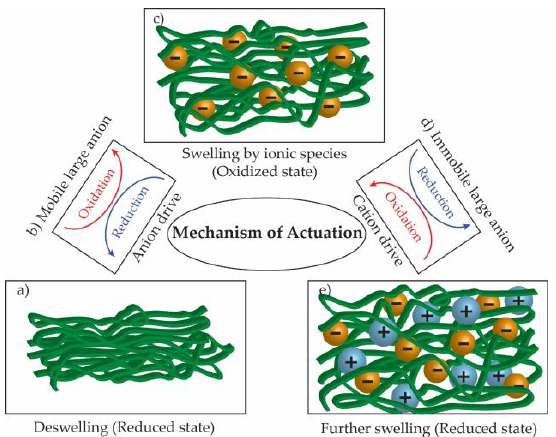
Figure 9. Mechanism of electrochemo-mechanical actuation in CPs. ( a, c, e ) Volume changes in CP via ( b , d ) two different redox pathways. ( b , d ) two different redox